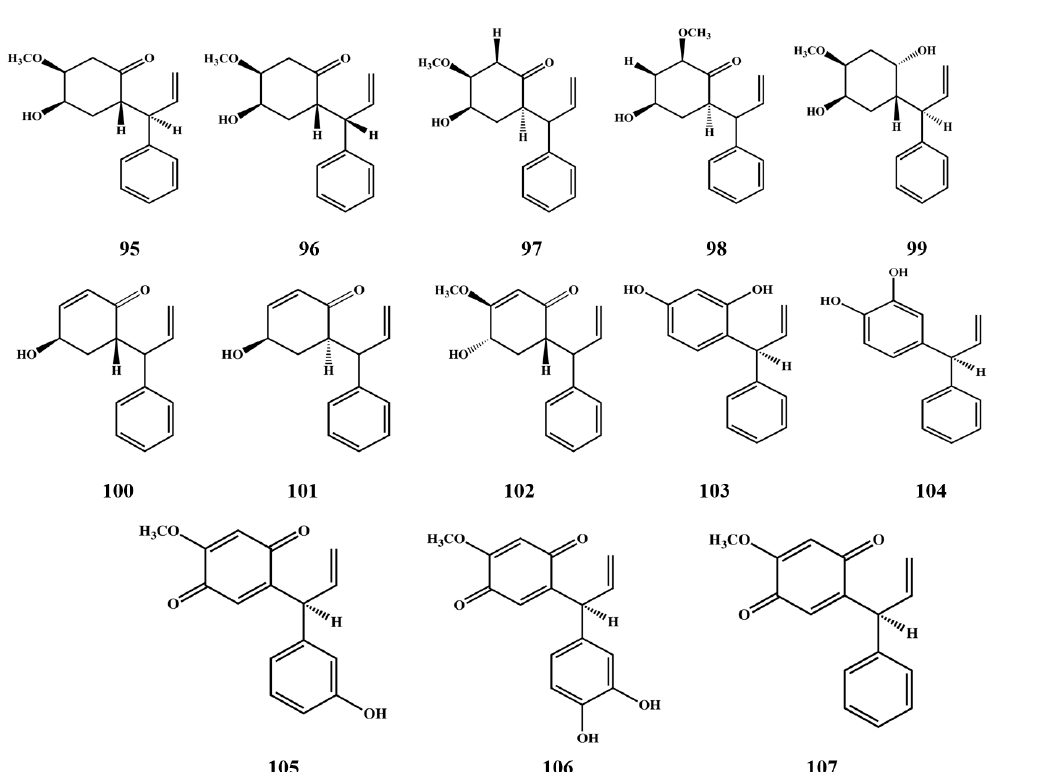
Figure 2. Open-chain neoflavonoids in